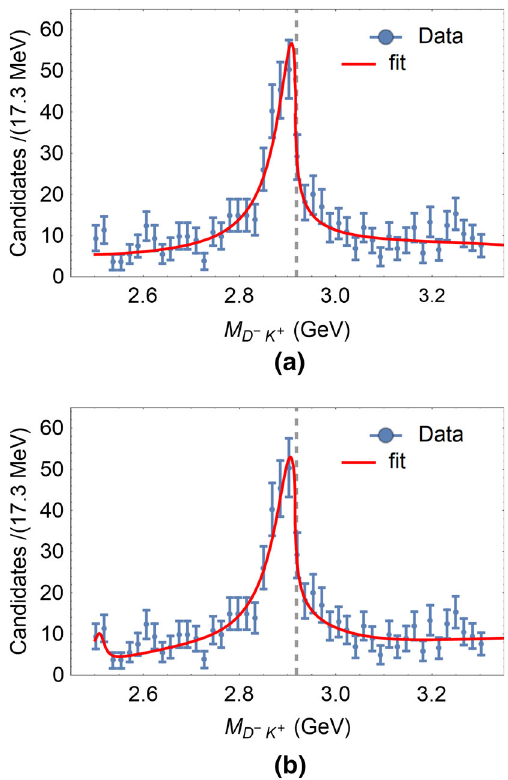
Fig. 1 The fit results using amplitude with final state interactions whose quantum numbers are I J P = 01 − (a) and I J P = 11 − (b). The fit goodness are χ 2 / d . o . f . = 42 . 95 / 40 and χ 2 / d . o . f . = 37 . 94 / 39, respectively. The dashed vertical line is located at ¯ D 1 K threshold. Data are from Ref. [1] Table 1 Parameters of two fits with dynamically generated X 1 ( 2900